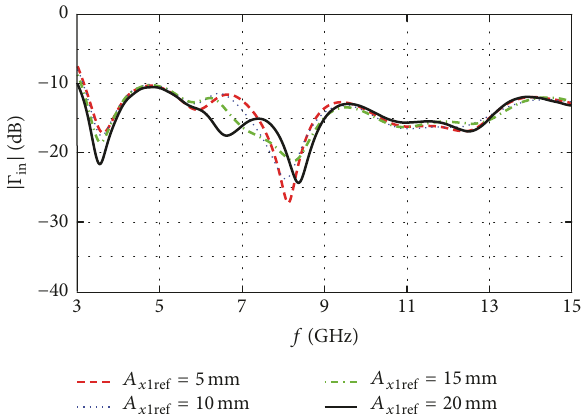
Figure 4: Magnitude of the input reflection coefficient versus frequency for the drop-shaped dipole antenna equipped with a metalreflectorcomputedfordifferentvaluesoftheparameter 𝐴 𝑥1 ref .